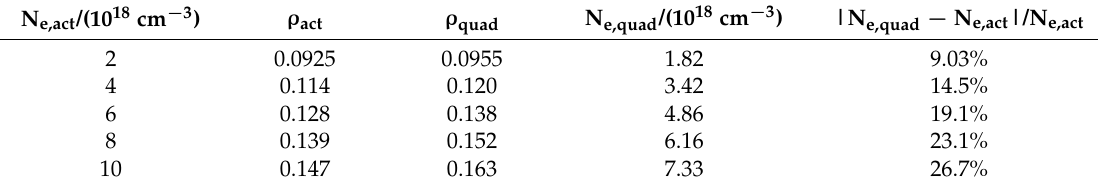
Table 1. The relative error in determining the electron density N e from the experimental asymmetry degree while disregarding the contribution of the penetrating ions for the He II Balmer-alpha line. The physical quantities in Table 1 are explained in the text directly above Table